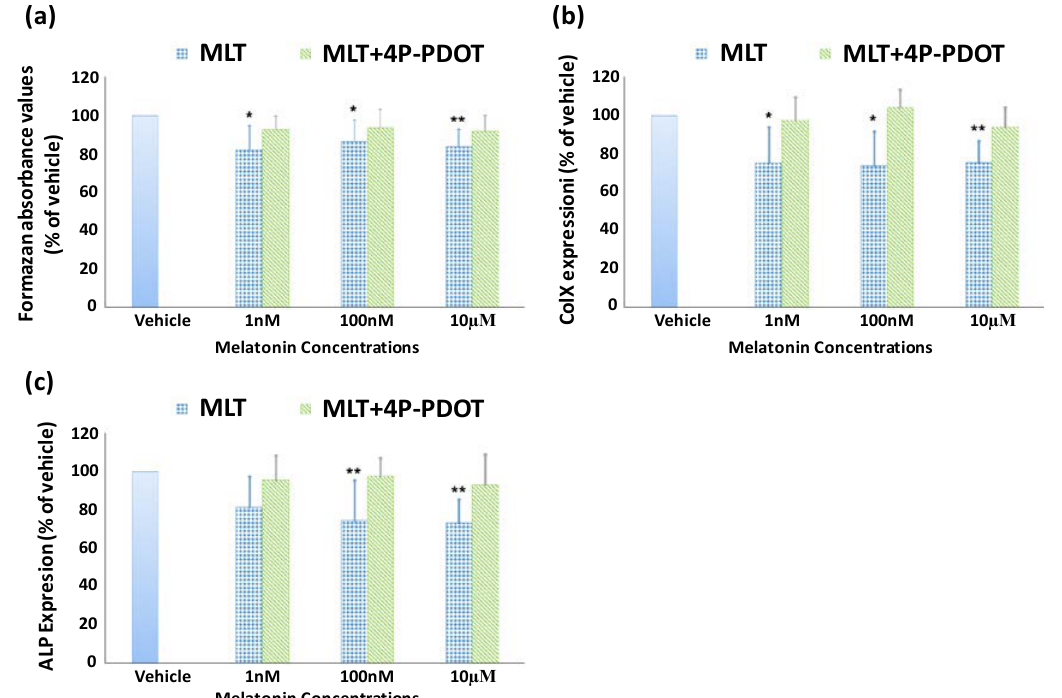
Figure 2. Effect of melatonin on the proliferation and gene expression of collagen type X ( COLX ) and alkaline phosphatase ( ALP ) in cultured GPCs from control subjects. Data represent mean ± standard deviation ( n = 10) The cell viability at the melatonin (MLT) concentration of 1, 100 nM and 10 µM was 82.2% ± 12.3%, 86.4% ± 11.0% and 83.8% ± 9.1% of that in the vehicle group, respectively. Significant differences were retrieved by One-sample t -test ( * p < 0.05, ** p < 0.01) ( a ); The expression of COLX ( b ) and ALP ( c ) was also reduced by melatonin especially at high concentrations. However, these inhibitory effects were reversed in the presence of 4-P-PDOT (10